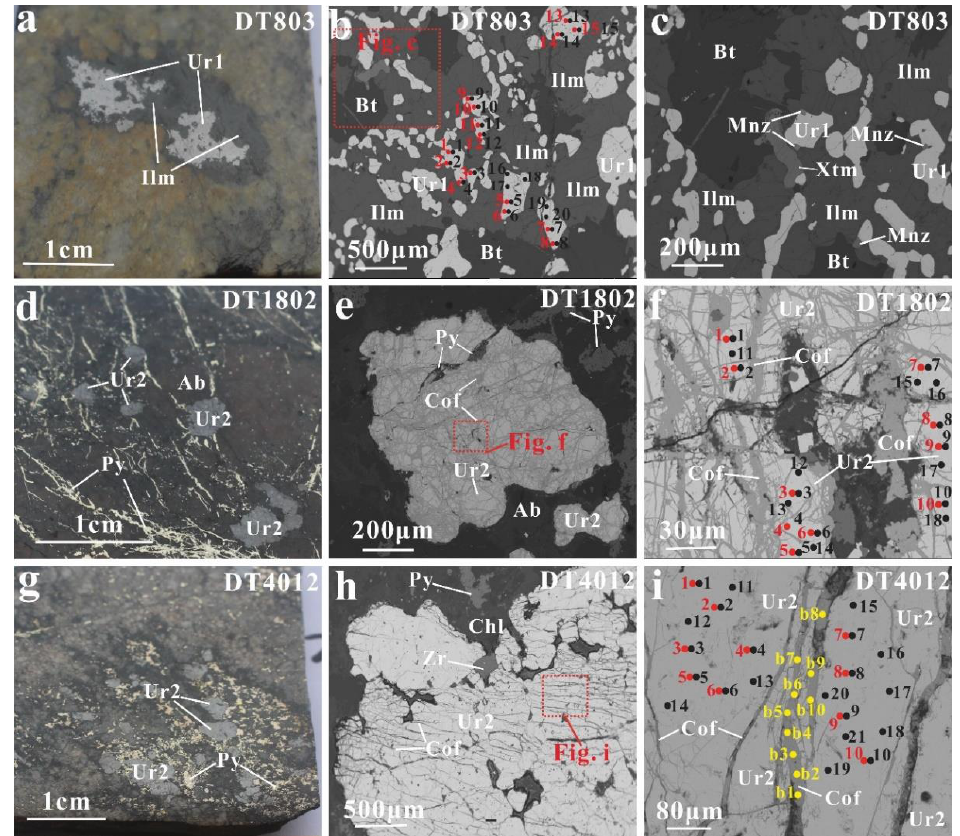
Figure 5. ( a , d , g ) Polished thin section photos and ( b , c , e , f , h , i ) backscattered electron (BSE) images showing the uraninite and associated minerals: ( a ) Ur1 uraninite associated with ilmenite; ( b ) Ur1 uraninite with a scattered distribution in il- menite; ( c ) Ur1 uraninite associated with xenotime, monazite, and ilmenite; ( d ) Ur2 uraninite associated with albite and granular and veined pyrite; ( e ) coffinite filling cracks in the Ur2 uraninite, forming a network of veins; ( f ) dendritic coffinite in the Ur2 uraninite; ( g ) Ur2 uraninite associated with granular pyrite; ( h ) Ur2 uraninite associated with zircon, chlorite, and pyrite; ( i ) fine-grained coffinite filling the fissures in the Ur2 uraninite. Mineral abbreviations: Ur — uraninite; Cof — coffinite; Py — pyrite; Ab — albite; Ilm — ilmenite; Bt — biotite; Xtm — xenotime; Mnz — monazite; Zr — zircon; Chl — chlorite. The red circles indicate the locations of the EMPA spots on the uraninite. The black circles indicate the locations of the LA- ICP-MC spots on the uraninite. The yellow circles indicate the locations of the LA-ICP-MC and EMPA spots on the coffi- nite.